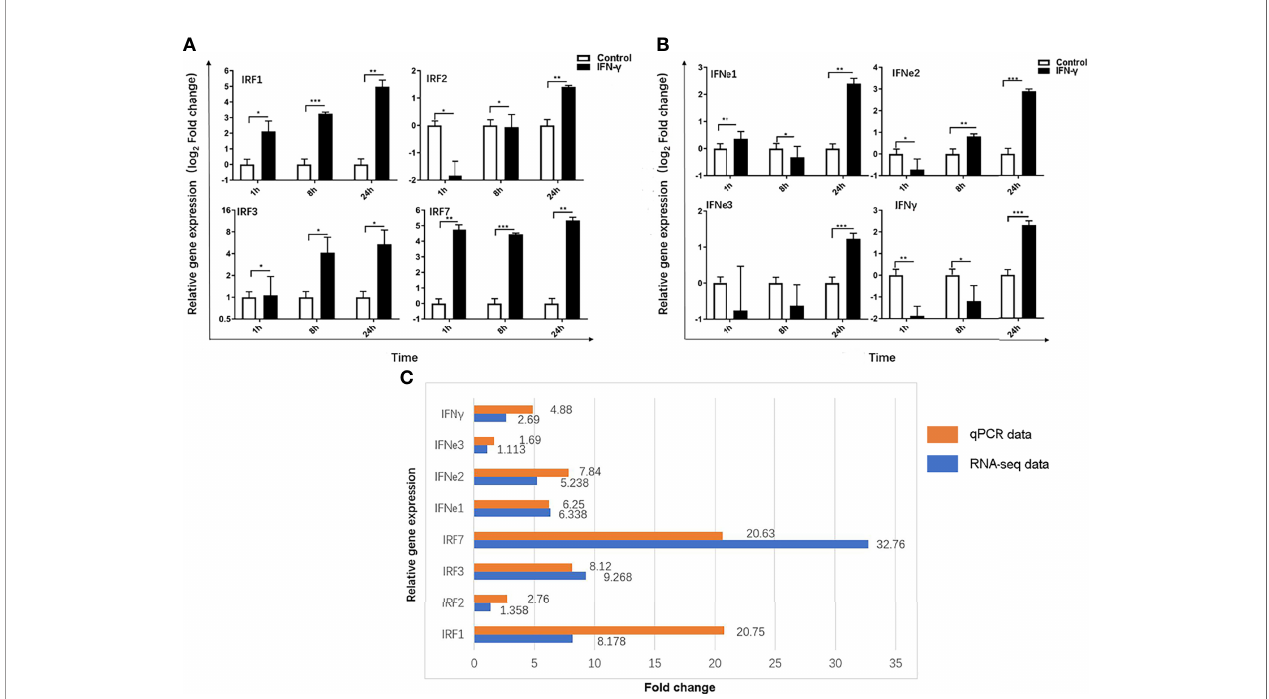
FIGURE 6 | Immunity-related genes expression induced by IFN- g of Acipenser sinensis. (A) Relative expression of IRF1, 2, 3 and 7 induced by IFN- g of Acipenser sinensis. (B) Relative expression of IFN – g , IFN-e1,2,3 induced by IFN - g of Acipenser sinensis. (C) Fold change of 8 immune genes DEG screened by qPCR and transcriptome. The vertical axis represents the name of the gene and the horizontal axis represents the multiples, red represents qPCR data and blue represents transcriptome data results. P -values of less than 0.05 were considered statistically signi fi cant (*P<0.05, **P<0.01,